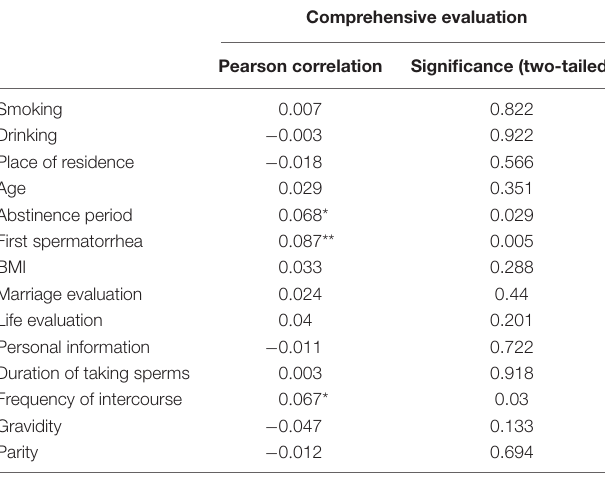
TABLE 4 | Correlation detection of semen quality influencing factors in whole